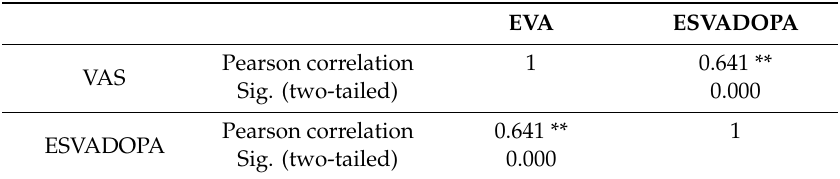
Table 5. Bivariate